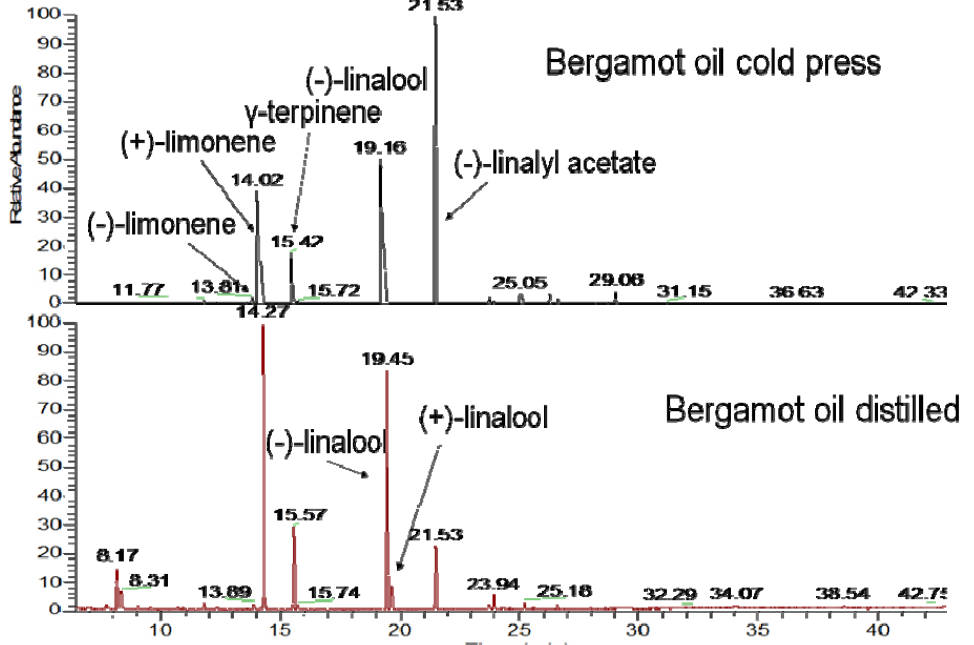
Figure 2. Comparison of bergamot oil obtained from the same raw plant material either by cold pressing or by hydrodistillation using GC-MS analysis with enantiomeric column b- DEX